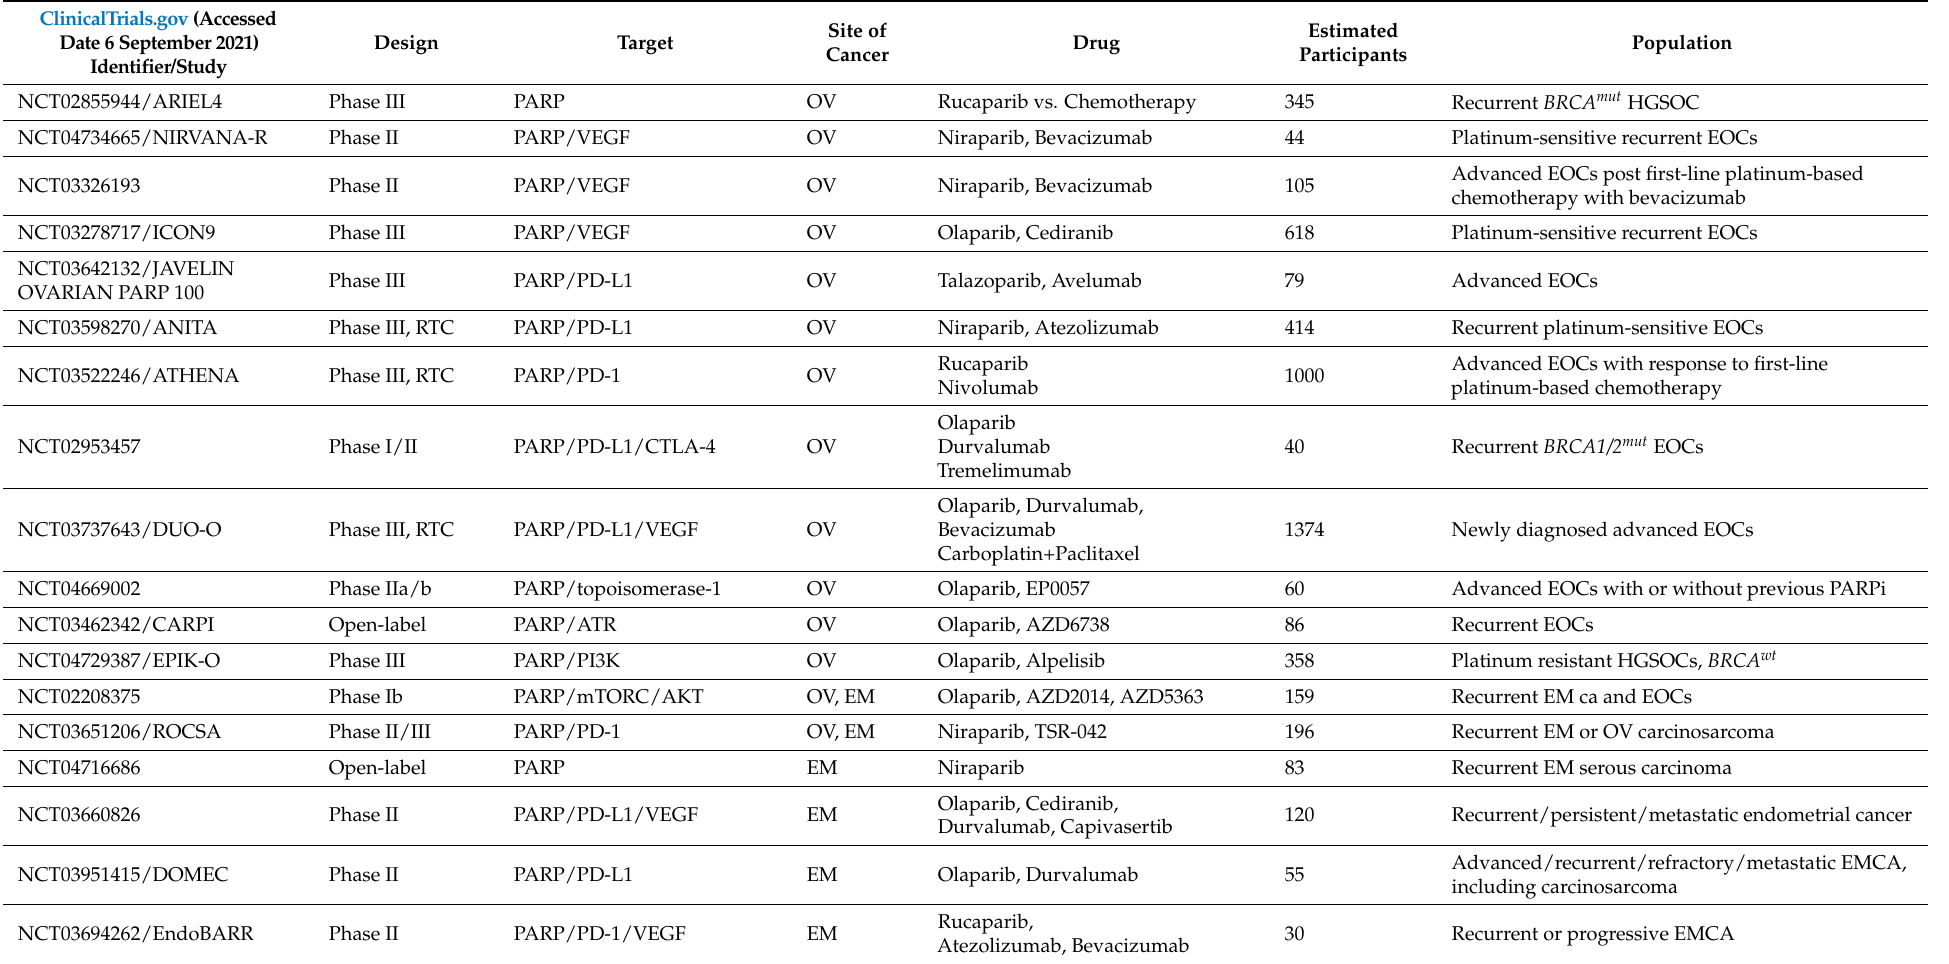
Table 2. Select ongoing trials or trials with results pending of PARP inhibitor studies in gynecologic